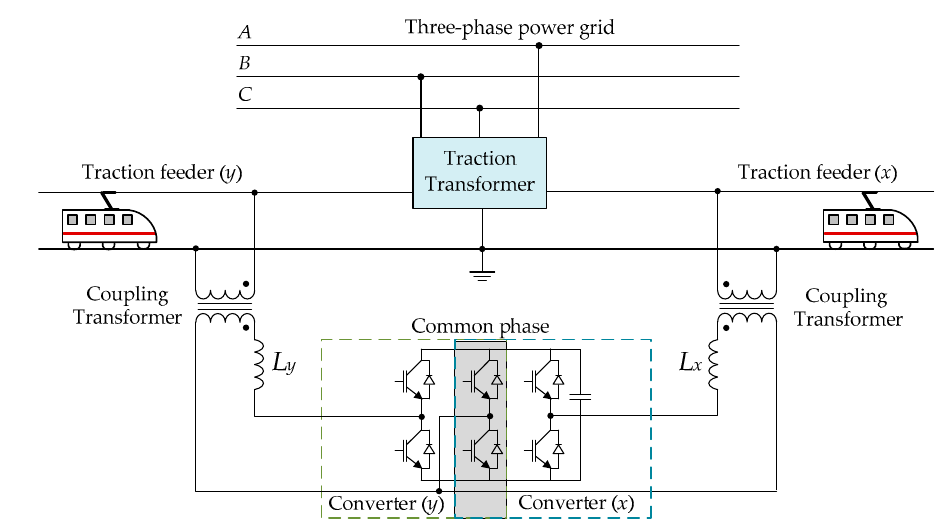
Table 6. Components quantities of the TW-RPC.